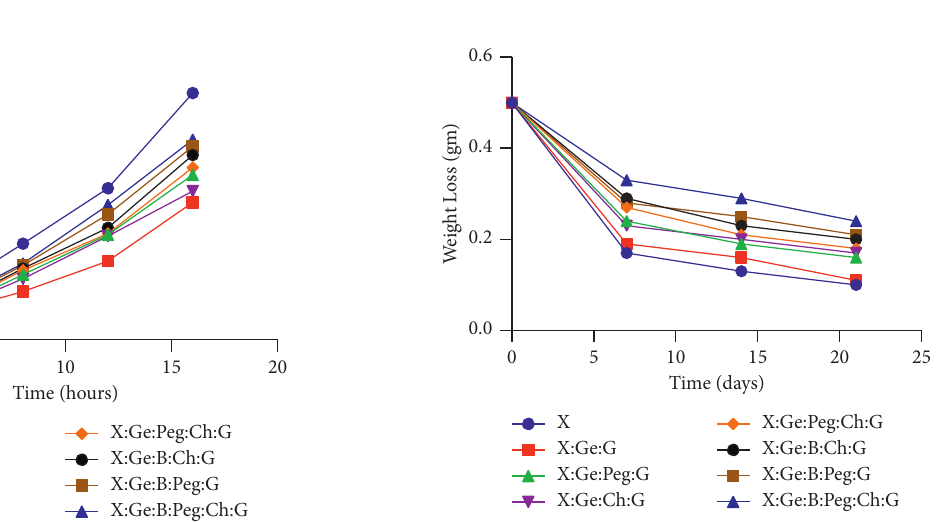
Figure 3: Swelling ability of hydrogel composites. After 16 hours, the swelling ratio of all hydrogels ranged from 3.89 to 6.98, con- firming their suitability for use as a wound dressing. A swelling ratio of 6.98 was observed in hydrogels made only from (X). When gelatin and glutaraldehyde were used in the mixture, the swelling ratio was drastically lowered to 3.89. (i.e., X: Ge: G). Abbreviations. Xanthan gum (X), boric acid (B), gelatin (Ge), polyethylene glycol (Peg), chitosan (Ch), and glutaraldehyde (G).